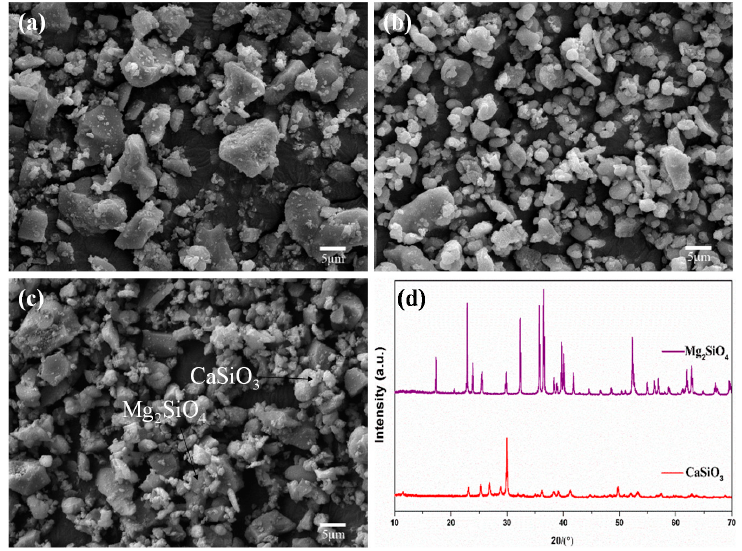
Figure 1. The microstructure of powders: ( a ) initial forsterite (Mg 2 SiO 4 ); ( b ) initial wollastonite (CaSiO 3 ); ( c ) mixed powders; and ( d ) X-ray diffraction (XRD)